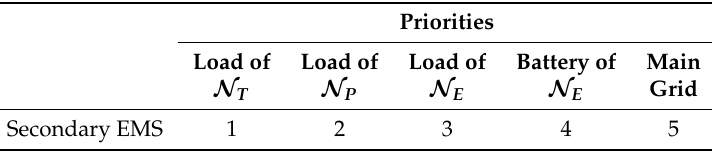
Table 4. Power sharing priorities of the secondary EMS.